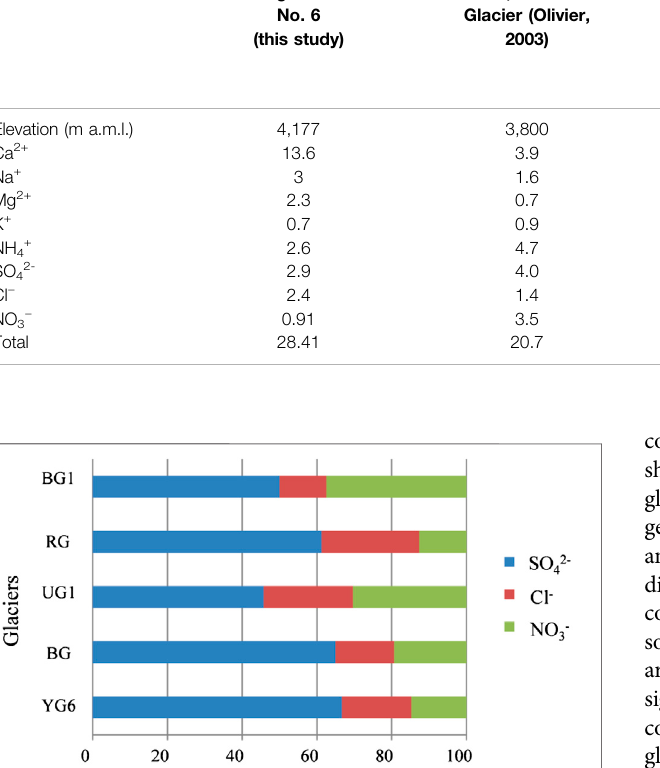
TABLE 4 | Concentrations of major ions ( μ eq L − 1 ) in snow at various glaciers in China. Site